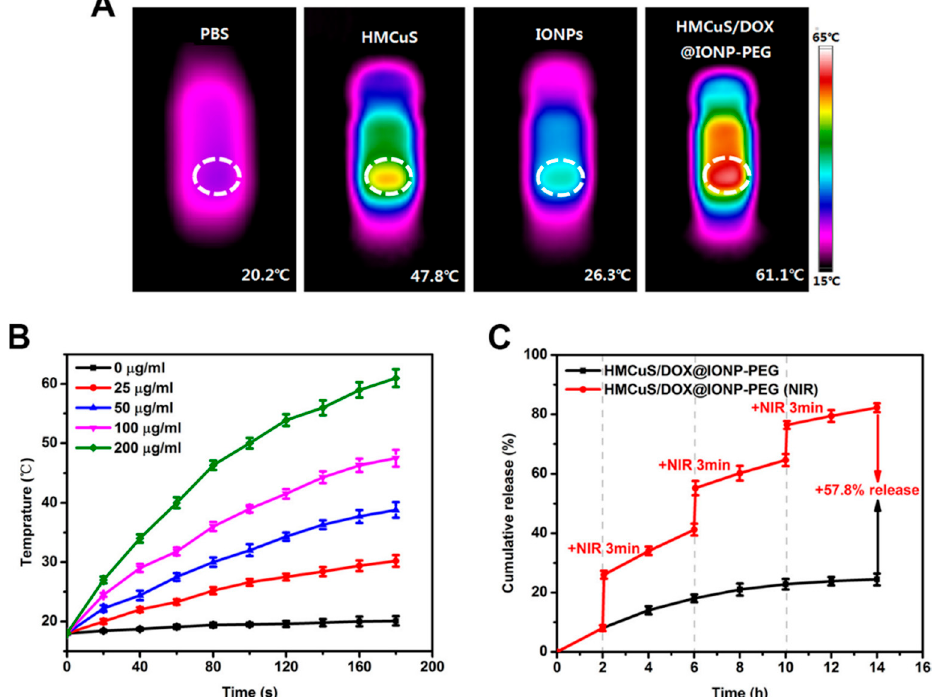
Figure 4. Photothermal heating effect and in vitro release profiles. ( A ) IR thermal images of tubes with phosphate buffer (PBS), hollow mesoporous CuS nanoparticles (HMCuS), iron oxide nanoparticles (IONs) and HMCuS/DOX@ION-polyethylene glycol (PEG) after irradiation by a 808 nm laser for 3 min; ( B ) the photothermal heating curves of HMCuS/DOX@ION-PEG with different concentrations after irradiation by an 808 nm laser; ( C ) release curves of doxorubicin (DOX) from the hybrid system with or without NIR irradiation. Reprinted with permission from Acta Biomater, 49, 402–413. Copyright 2016 [85].